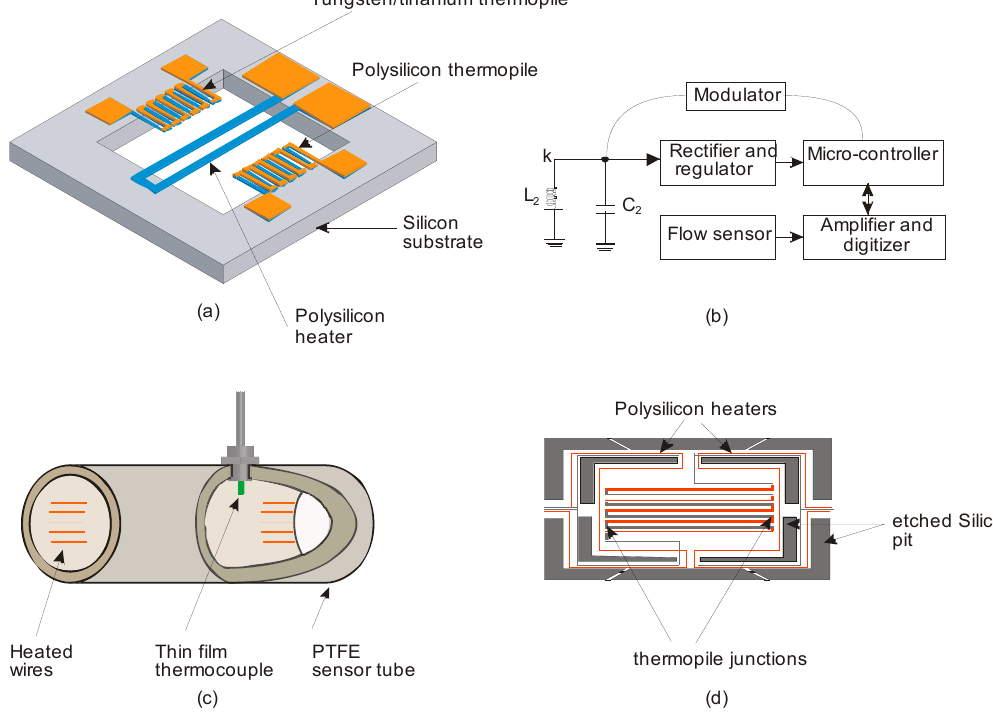
Figure 9. Examples of recently reported thermoelectric flow sensors, ( a ) A high-temperature thermal flow sensor with membrane, heater and thermopiles; ( b ) Hardware block diagram of the wireless flow sensor developed by Gould et al.; ( c ) Time of flight thermal flow sensor for large scale containment facility; ( d ) Top view of a thermal flow sensor showing reference and sample heaters along with five thermopile junctions on each side.